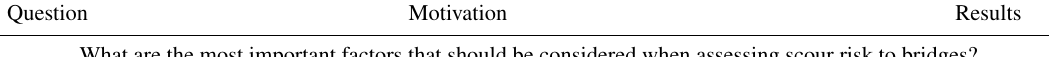
Table 1. Summary of specific questions posed in the elicitation workshop.